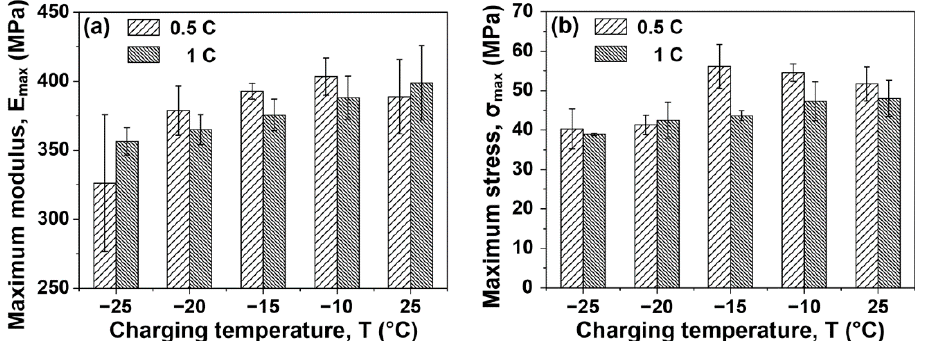
Figure 5. Relationships between the charging environmental temperatures and charging rates of 18650 LIB cells and their ( a ) maximum nominal moduli E max and ( b ) maximum load stresses σ max.